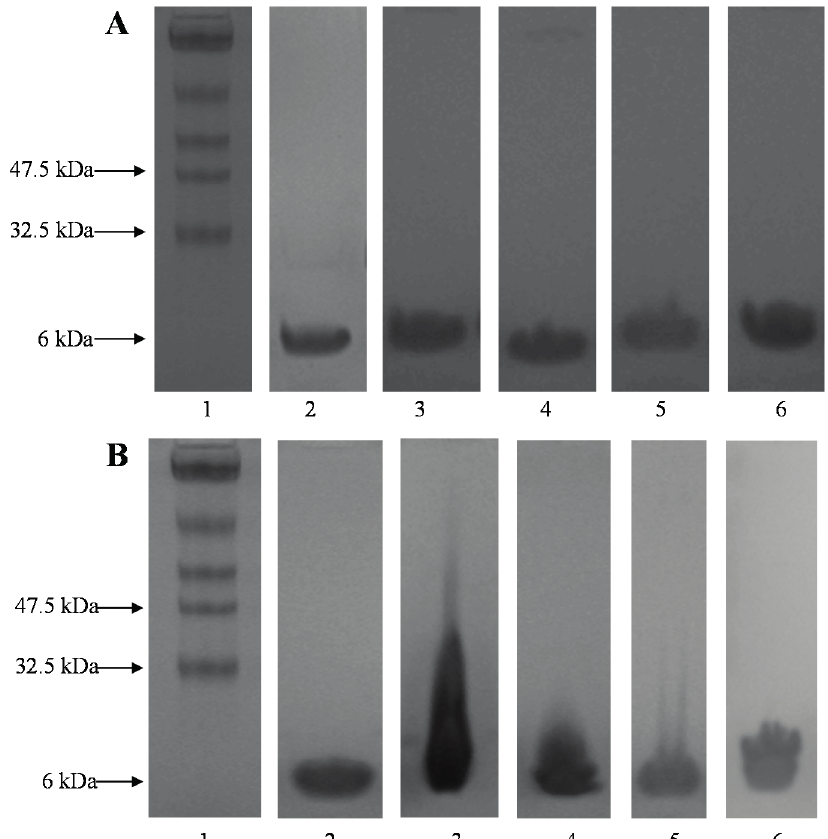
Figure 3. ( A ) Sodium dodecyl sulfate-polyacrylamide gel electrophoresis (SDS-PAGE) of insulin extracted into the aqueous phase; and ( B ) SDS-PAGE of insulin obtained from the interfaces after various emulsification conditions. Lane 1: standard protein markers, lane 2: native insulin, lane 3: insulin obtained after homogenization at 5000 rpm, lane 4: insulin obtained after homogenization at 10,000 rpm, lane 5: insulin with zinc after homogenization at 5000 rpm, and lane 6: insulin with zinc after homogenization at 10,000